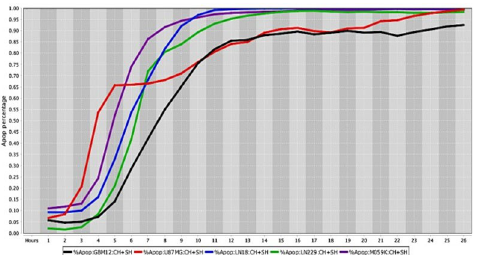
Fig 9. Cell death response curves for human glioblastomas. Cell death response expressed in percentage of apoptosis in human glioblastoma cell lines (GBM12- black line, U87MG- red line, LN18- blue line, LN229- green line, M059K- purple line) exposed to CT at 20 μ M, HO-3867 at 10 μ M, and SH-4-54 at 5 μ M